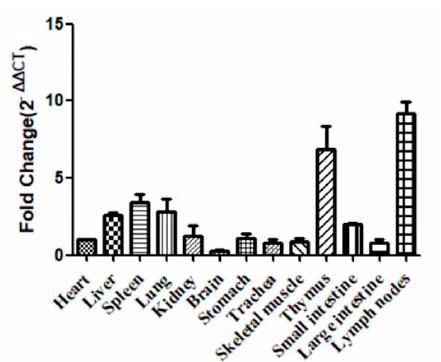
Figure 3. The distribution of the canine tetherin gene in various tissues. Samples were analysed in triplicate, and GAPDH (Glyceraldehyde-3-phosphate dehydrogenase gene) was used as an endogenous control for normalization. Fold changes were calculated using the 2 − ∆∆ C T method. The error bars represent the standard deviation.